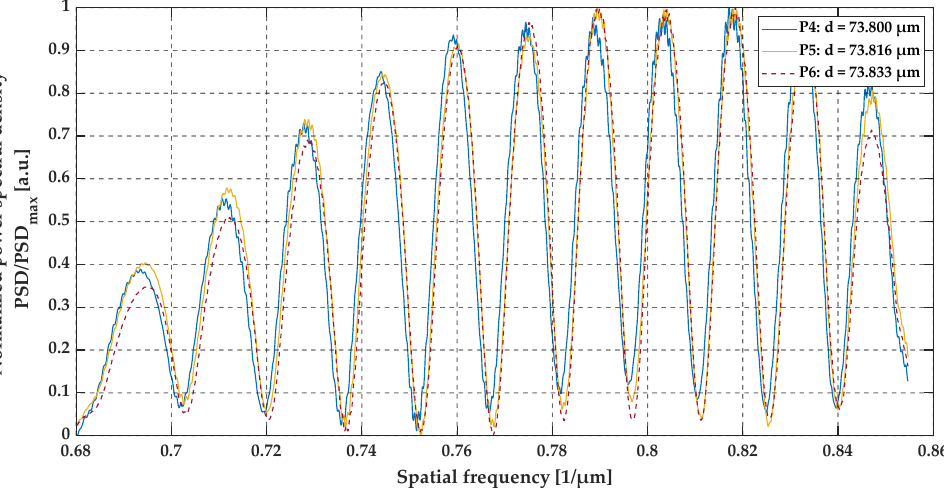
Figure 19. The envelopes of preprocessed data at positions P4, P5, and P6.